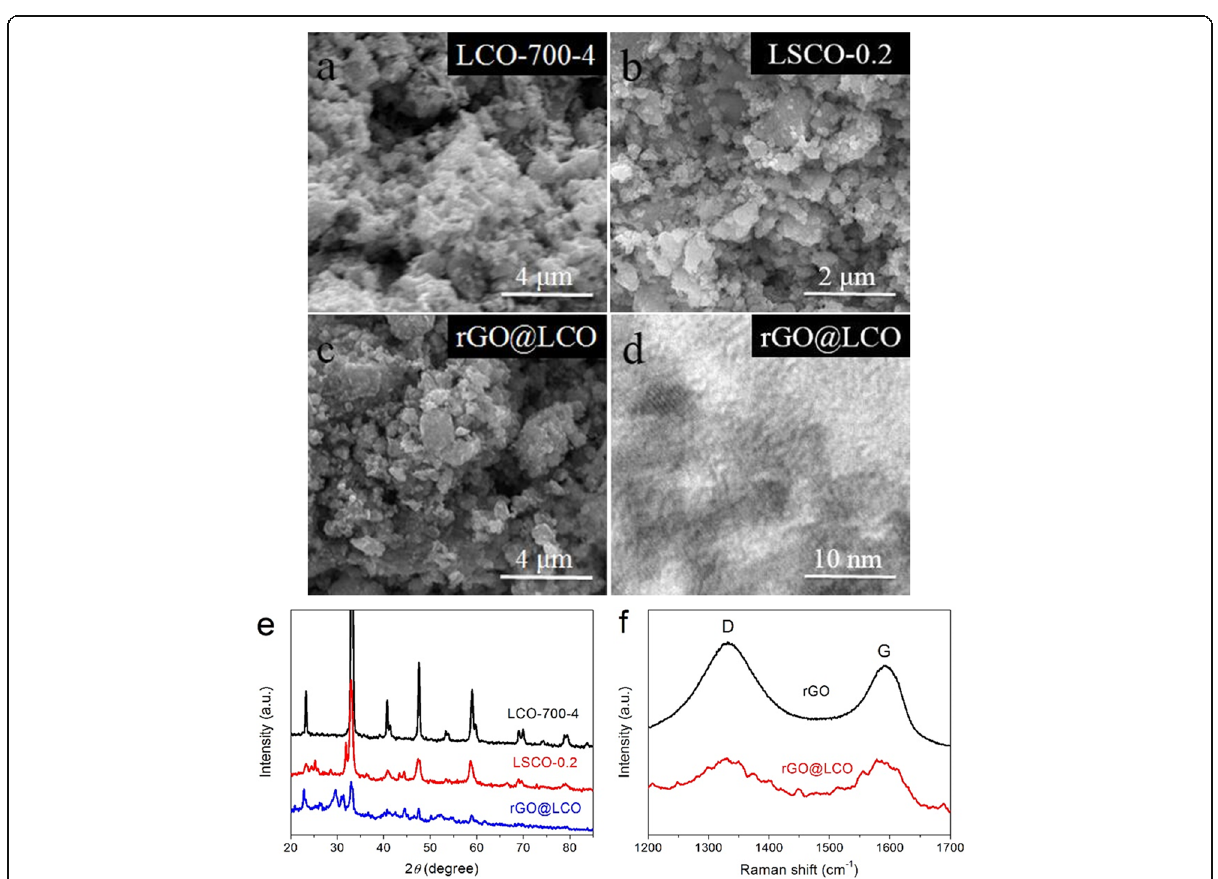
Fig. 4 a – c SEM images of the LCO-700-4, LSCO-0.2, and rGO@LCO samples. d HRTEM image of rGO@LCO composite. e XRD patterns of the LCO- 700-4, LSCO-0.2, and rGO@LCO samples. f Raman spectra of rGO and rGO@LCO